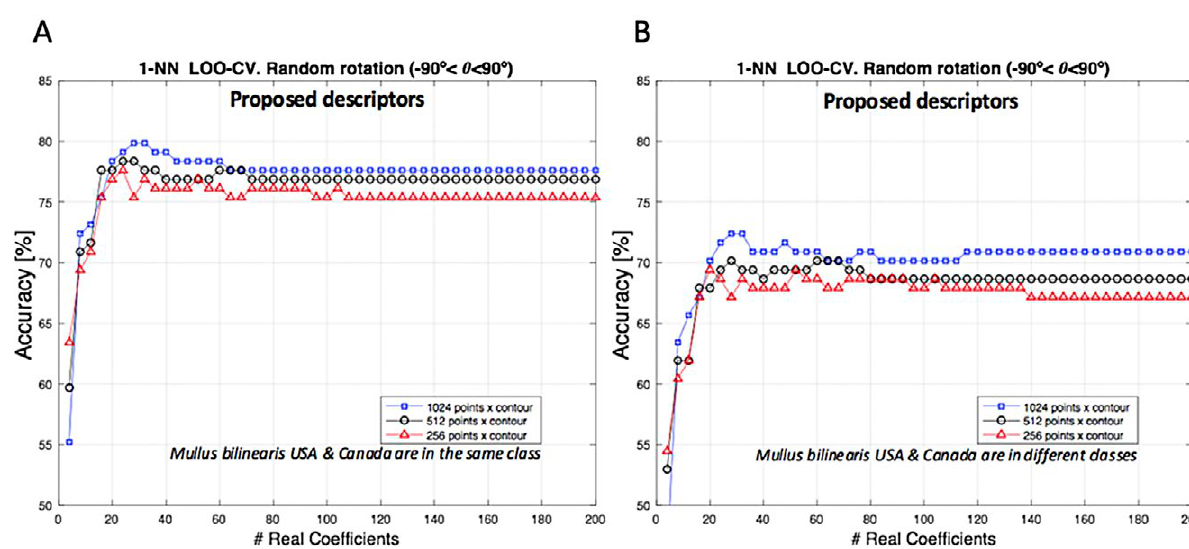
Fig. 6. – k -NN ( k =1) classification result with LOOCV for # real coefficients employed and the number of points per contour (256, 512 and 1024). All incoming contours are randomly rotated in a range of between –85° and +85°, are sampled in anti-clockwise, and have a random initial sampling point. In A, the groups of M. bilinearis collected in Canada and M. bilinearis collected in the USA are considered to belong to two different classes, and in B these groups are considered to belong to the same class.